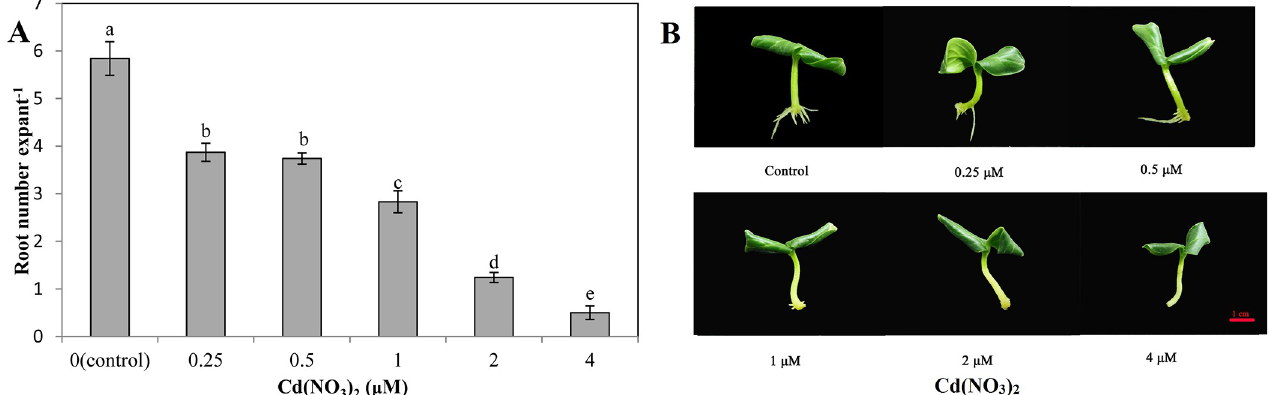
Fig 1. Effects of different concentrations of Cd(NO 3 ) 2 on the adventitious rooting in cucumber explants. The primary roots were removed from hypocotyls of 5-day-old cucumber seedlings. Explants were incubated for 5 days with distilled water (control) or different concentrations of Cd(NO 3 ) 2 (0.25, 0.5, 1, 2 and 4 μ M). Adventitious root numbers ( A ) were expressed as mean ± SE. Bars not sharing the same letters were significantly different ( P < 0.05). Photos ( B ) were taken 5 days after the treatment, bar = 1cm.